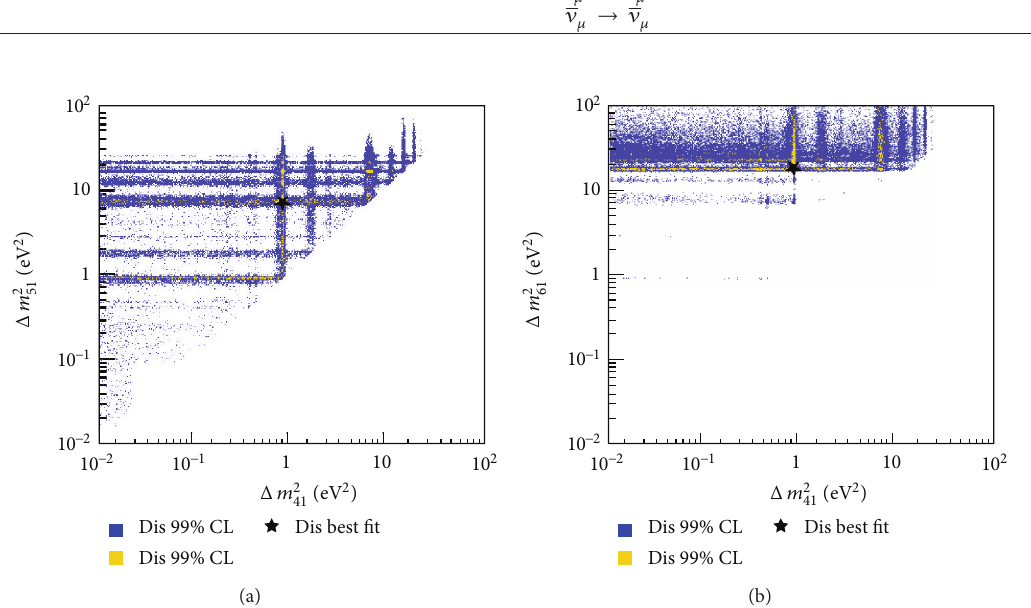
Figure 12: The Δ𝑚 2 51 versus Δ𝑚 2 41 and Δ𝑚 2 61 versus Δ𝑚 2 41 correlations from fits to disappearance data in a ( 3 + 3 )